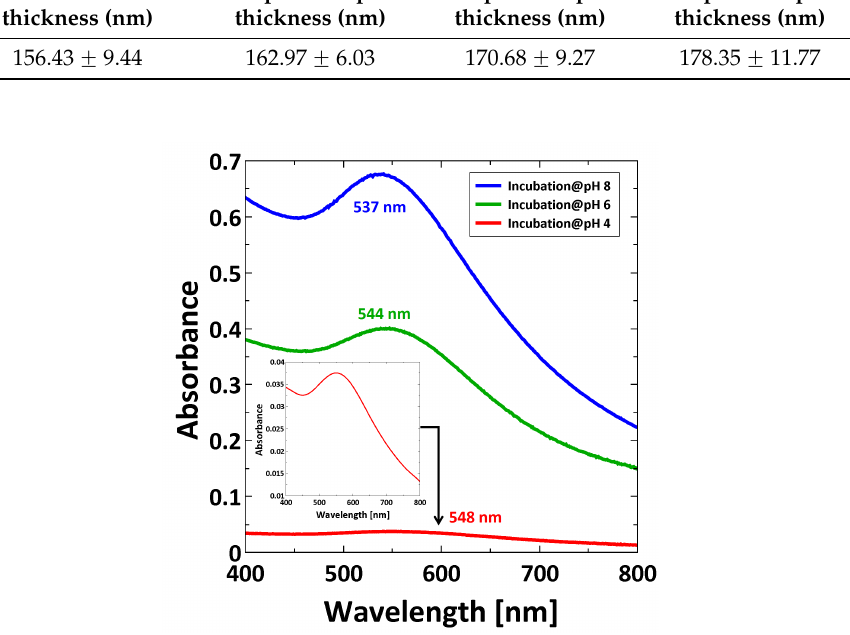
Figure 7. UV/Vis spectra recorded in water for PMETAC/AuNP composites incubated at pH 4, at pH 6, and at pH 8. Magnified representation of the SPR band for PMETAC/AuNP composite at pH 4